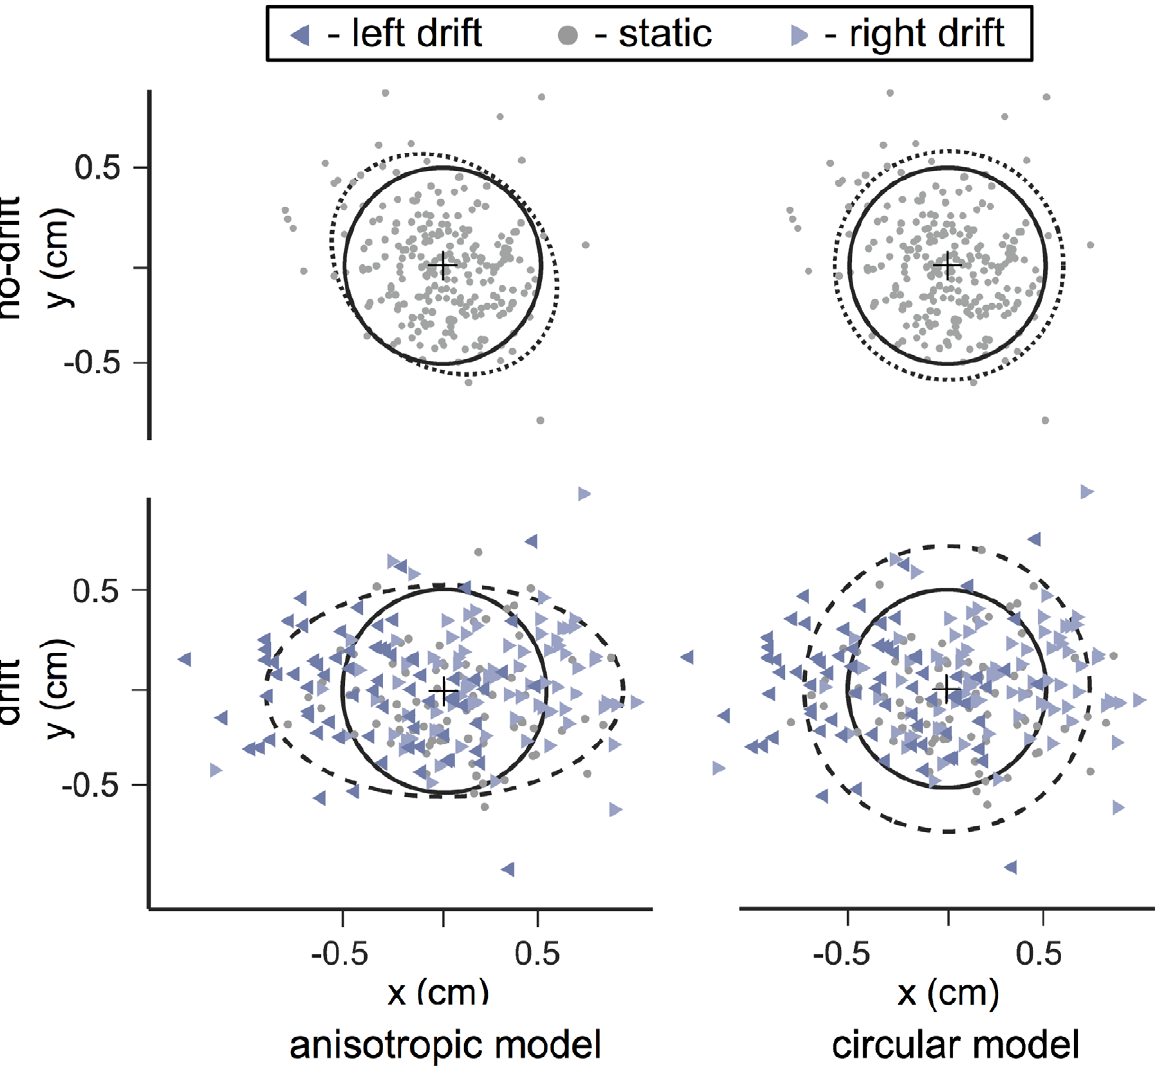
Figure 2. Effects of movement perturbation on movement endpoints. Movement endpoints are shown for subject S4 for zero-penalty trials aiming at the green target circle. Solid circles represent the 1 cm target region. Upper row: no-drift session. Lower row: drift session. Left column: dotted and dashed curves are 2-SD covariance ellipses. Right column: Dotted and dashed curves are 2-SD circles of an isotropic Gaussian fit to the data. Different symbols indicate the drift condition.